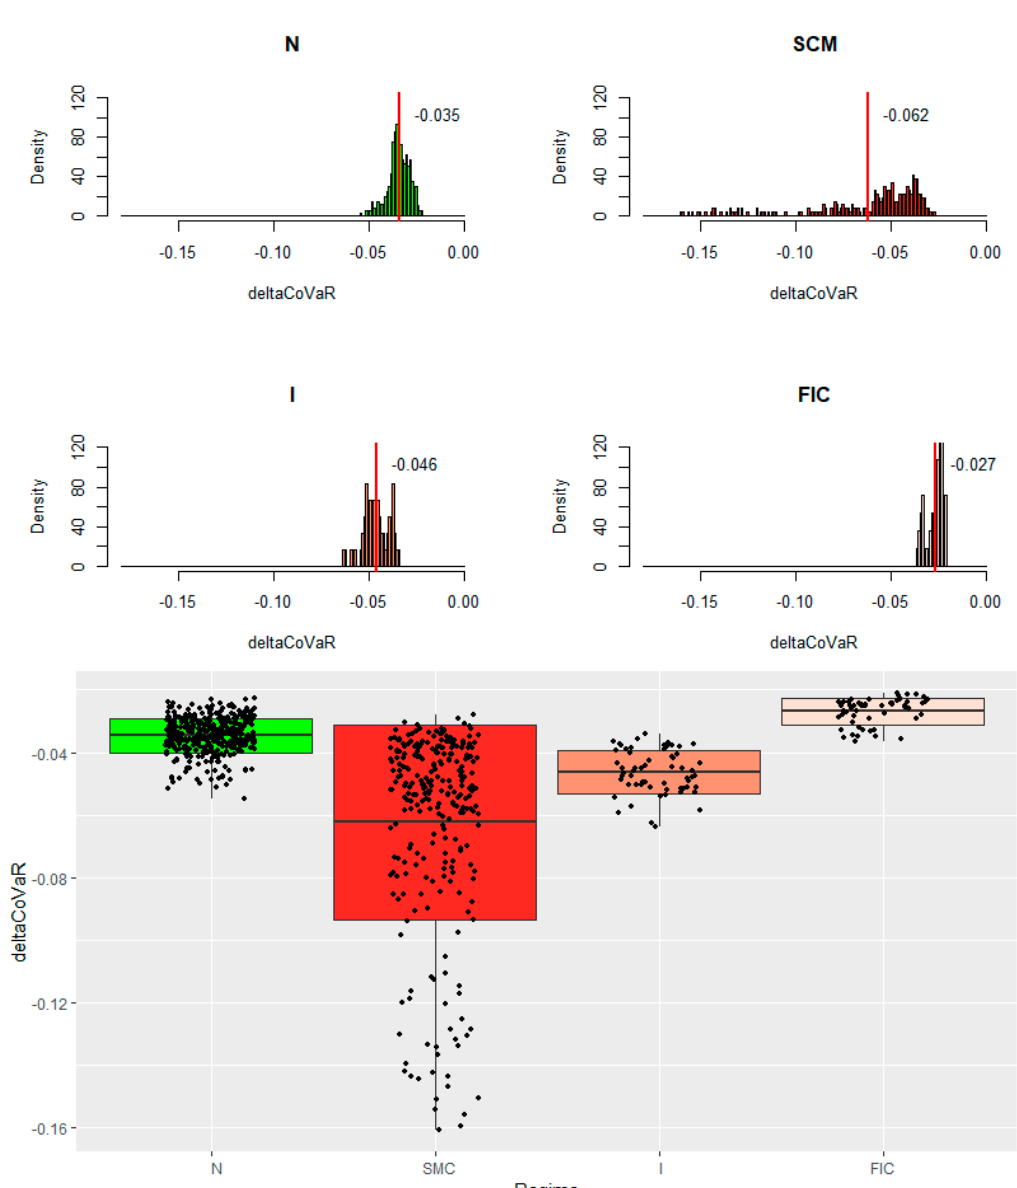
ff erent market states. Source: Own